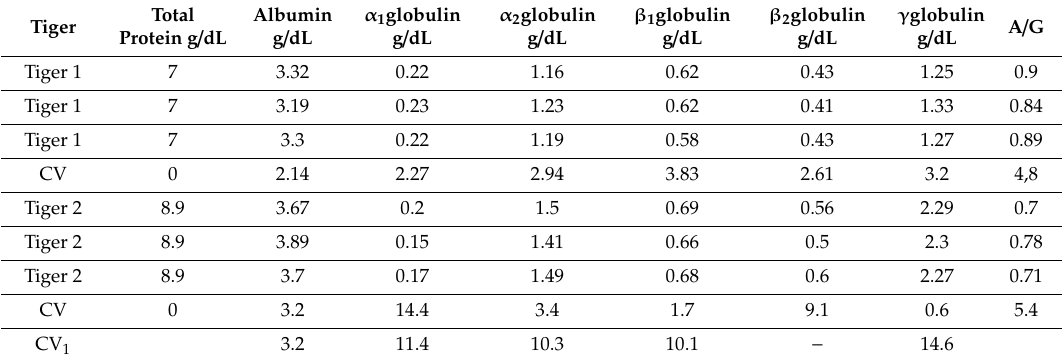
Table 2. Serum protein electrophoresis in 2 healthy captive tigers serum samples tested 3 times on the same day, in the same laboratory and interpreted in duplicate by two operators. Coe ffi cient of variability (CV) of total protein, albumin and α 1 , α 2 , β 1 , β 2 and γ globulin calculated as SD / mean ×